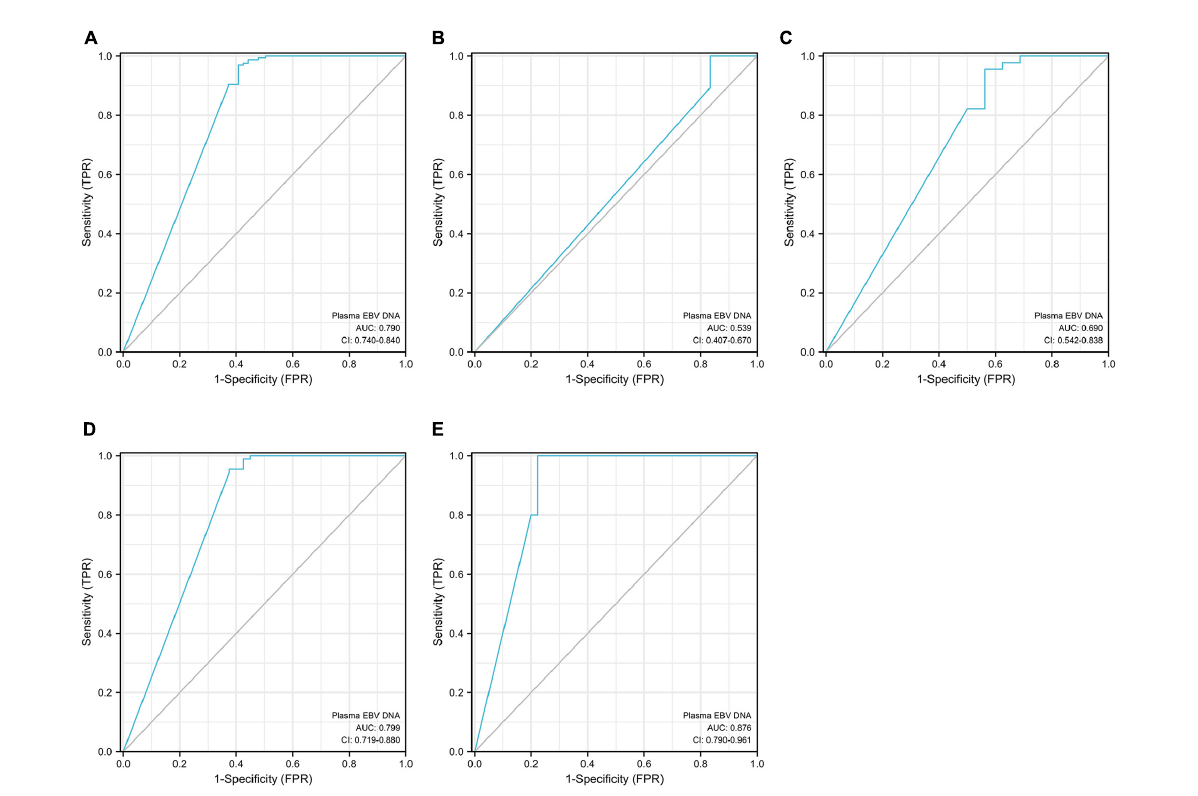
FIGURE4 Area under the curve (AUC) for circulating cell-free EBV DNA in distinguishing EBVaGC from EBVnGC. Panel (A) for the total gastric cancer; panel (B) for the stage TNM I subpopulation; panel (C) for the stage TNM II subpopulation; panel (D) for the stage TNM III subpopulation; panel (E) for the stage TNM IV